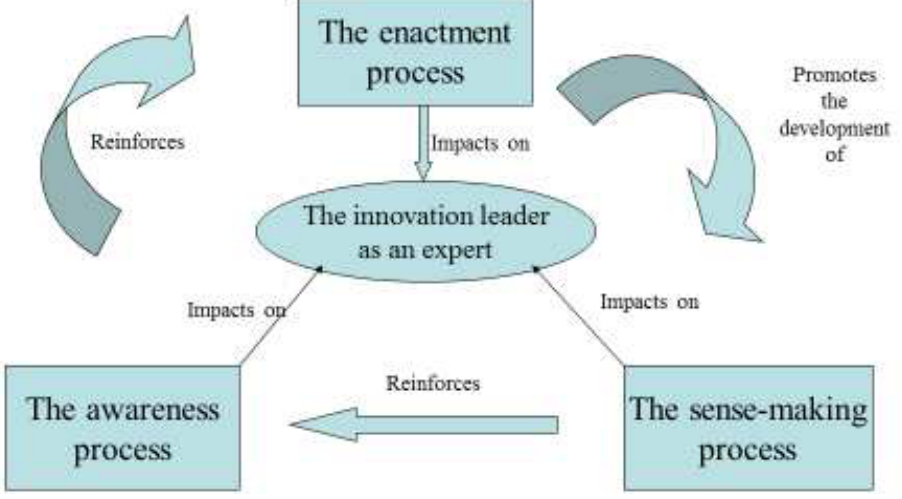
Fig. 2. The innovation leader as an expert: three